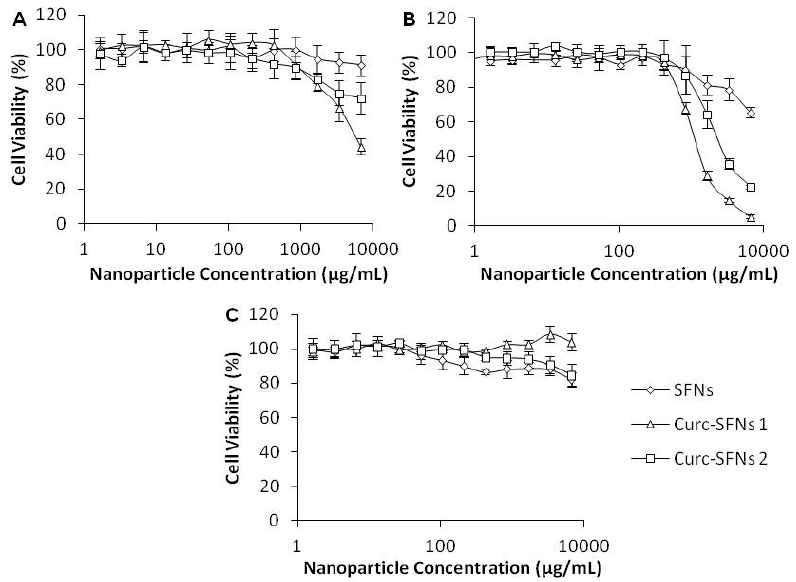
Figure 5. In vitro cytotoxicity studies after 48 h of exposure to silk fibroin nanoparticles (SFNs), curcumin-loaded silk fibroin nanoparticles synthesized by physical adsorption (Curc-SFNs 1) and curcumin-loaded silk fibroin nanoparticles synthesized by coprecipitation (Curc-SFNs 2): ( A ) Hep3B cells; ( B ) Kelly cells; and ( C ) hMBSCs.